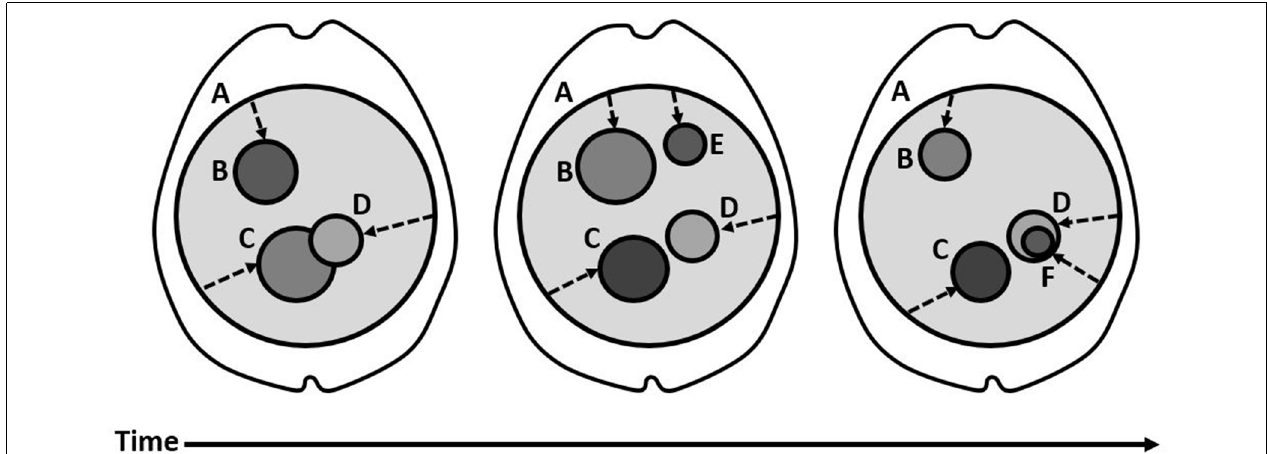
FIGURE 1 | The Structure of the Temporally-Integrated Causality Landscape . (A) The large, light gray circle corresponds to the System, which has a non-zero level of TIC and covers a substantial area of the thalamus and cortex. Over time, the System persists with little overall change. The dotted arrows are meant to show that the System is the point of view upon the nested Subsystems. (B–F) The smaller, darker gray circles correspond to Subsystems within the System. (B) This Subsystem shows a change in size and TIC (darkness of color) over time, with less TIC and spatial extent in the third panel relative to the first. (C) This Subsystem shows a change in size and TIC over time, with higher TIC but smaller spatial extent in the third panel than in the first. (D) This Subsystem shows some drift in position relative to Subsystem (C), over the three panels. In the third panel, it comes to contain a smaller Subsystem (F), which has even higher TIC (darker gray). (E) This Subsystem appears briefly in the second panel, then disappears again. F, This small Subsystem appears within the spatial domain of Subsystem D. It has a higher level of TIC (darker